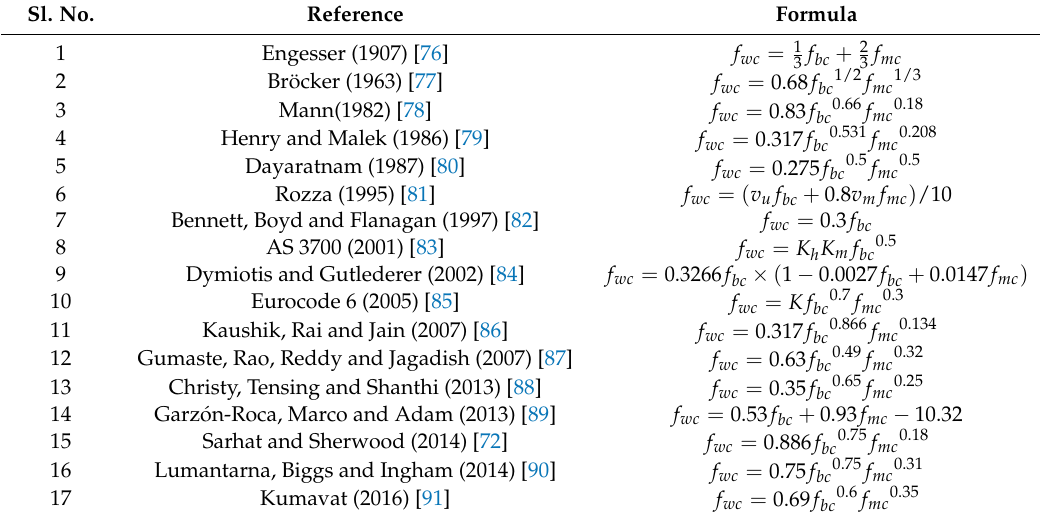
Table 1. Formulae for the estimation of masonry compressive